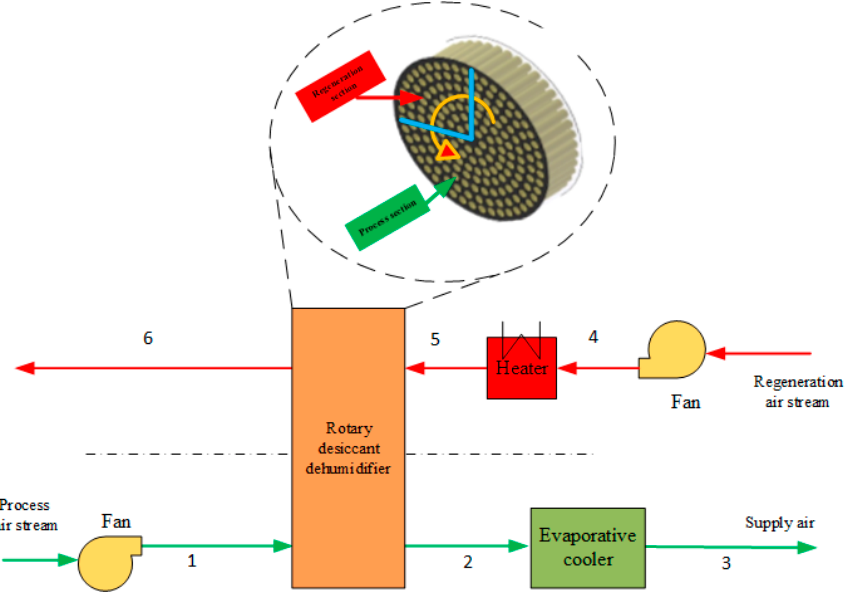
Figure 1. A schematic of the proposed rotary liquid desiccant cooling system.